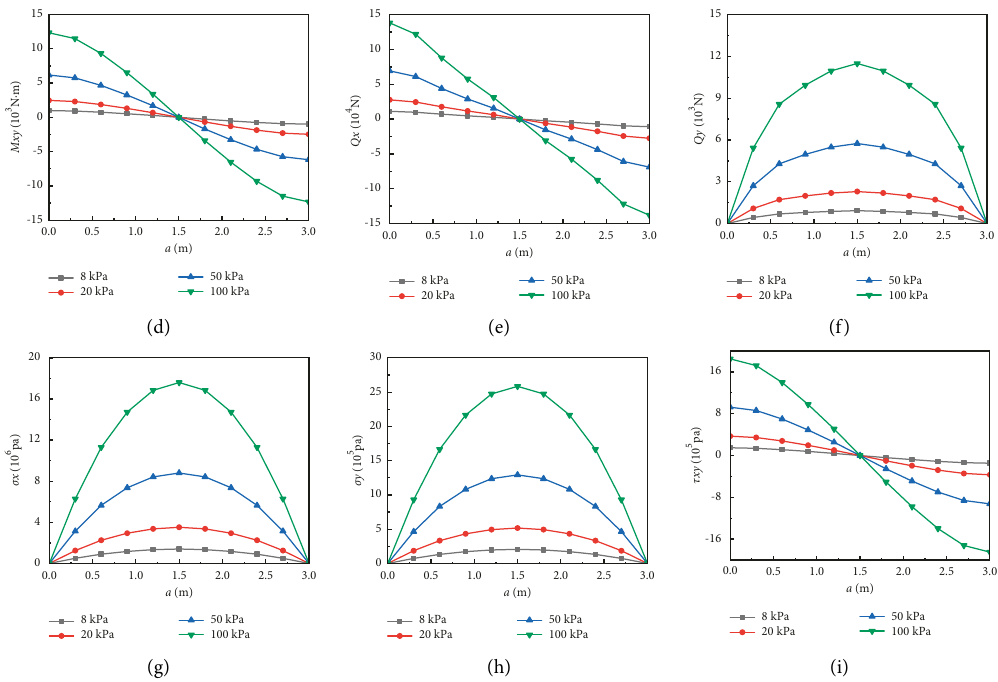
Figure 13: Effect of frost heaving force on deflection, internal force, and stress of the bottom